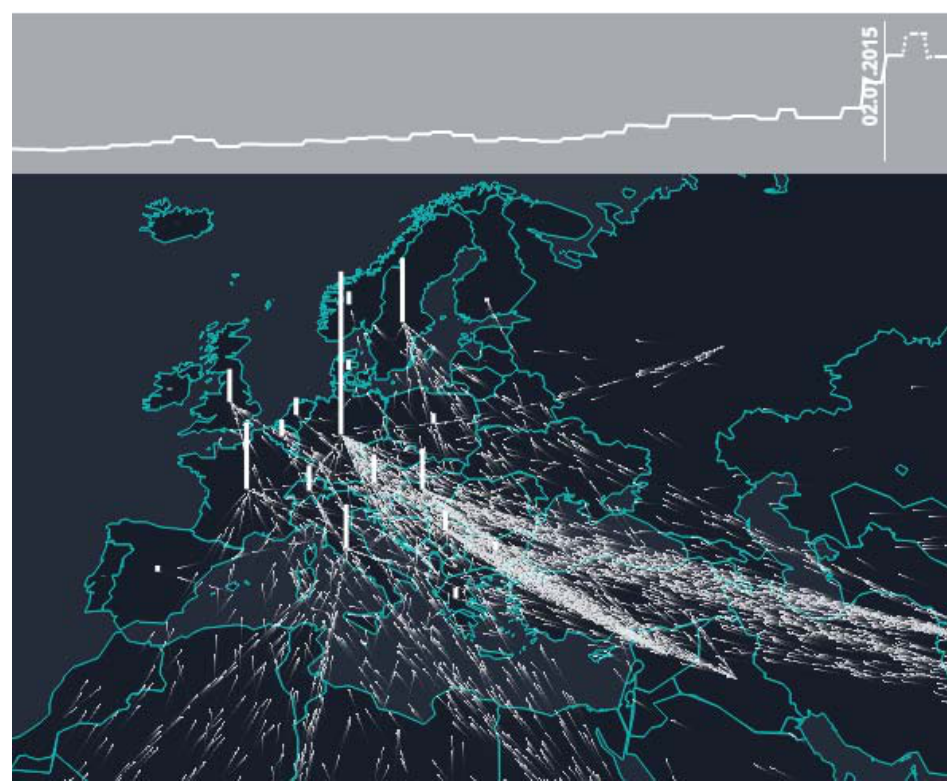
Figure1. Refugee flows from Africa and the Middle East to Europe in July 2015 with a histogram (on top) showing the daily numbers of asylum seekers (adapted from [1]).